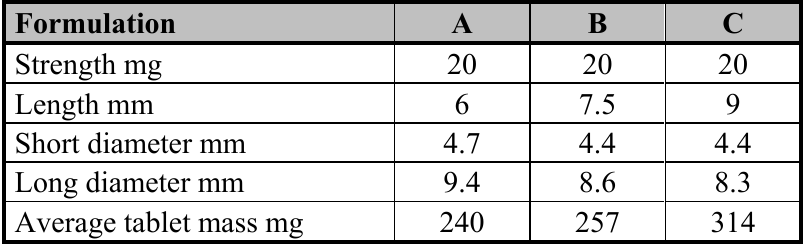
Table 1. Main formulation characteristics.